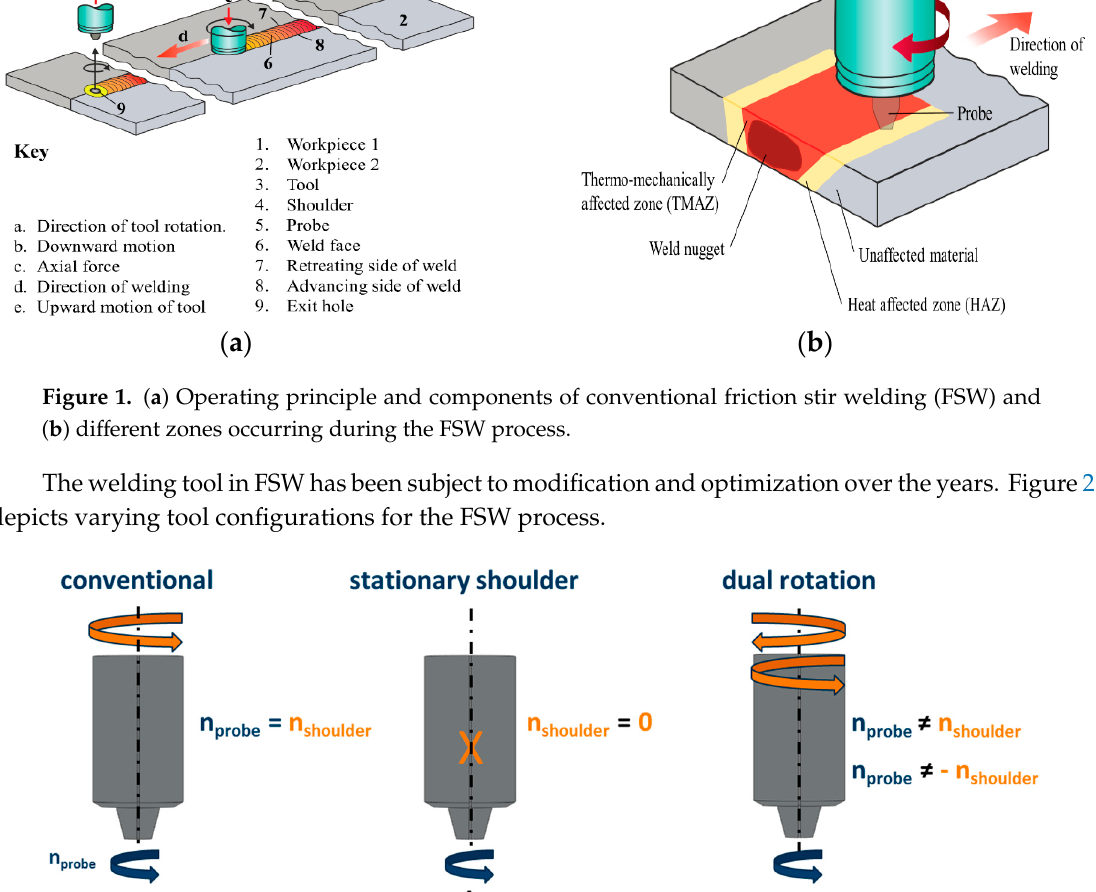
Figure 2. FSW with ( a ) conventional ( b ) stationary and ( c ) dual rotation tool configuration.